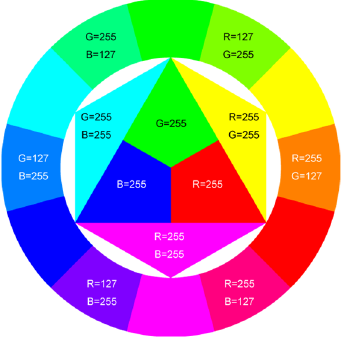
Figure 3 . The color value map of different colors . Figure 3. The color value map of different colors.